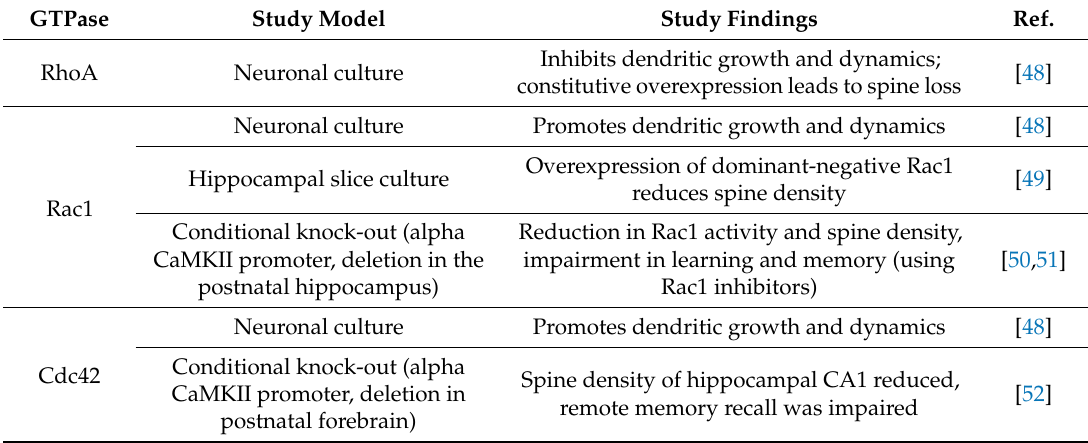
Table 1. Role of Rho GTPases on spine morphogenesis in vivo and in